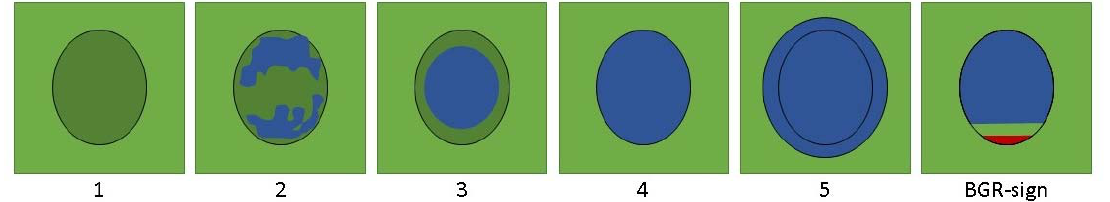
Figure 3. Tsukuba Elasticity Score (TES) scoring system after Itoh et al. and WFUMB guidelines by Barr et al. [16,17]. Elastographic patterns corresponding to a higher score are thought to be of higher risk of